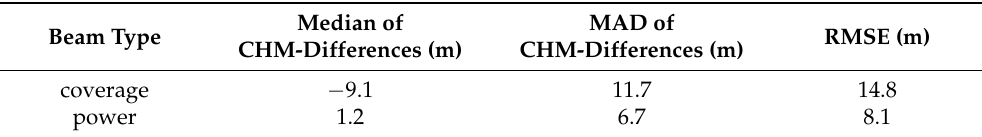
Table 4. Accuracy of GEDI-CHM estimates using rh_95 height metric depending on beam type (algorithm setting group number 5).